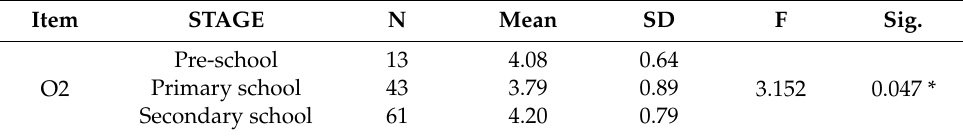
Table 3. Items with significant di ff erences depending on the advisory stage variable. Item STAGE